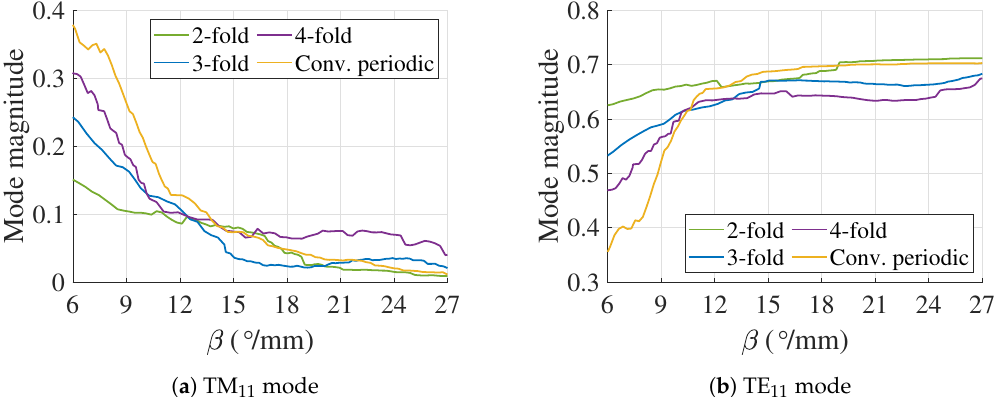
Figure 6. Magnitudes of the mode coefficients of the TM 11 and TE 11 modes. The dimensions and number of modes are the same as in Figure